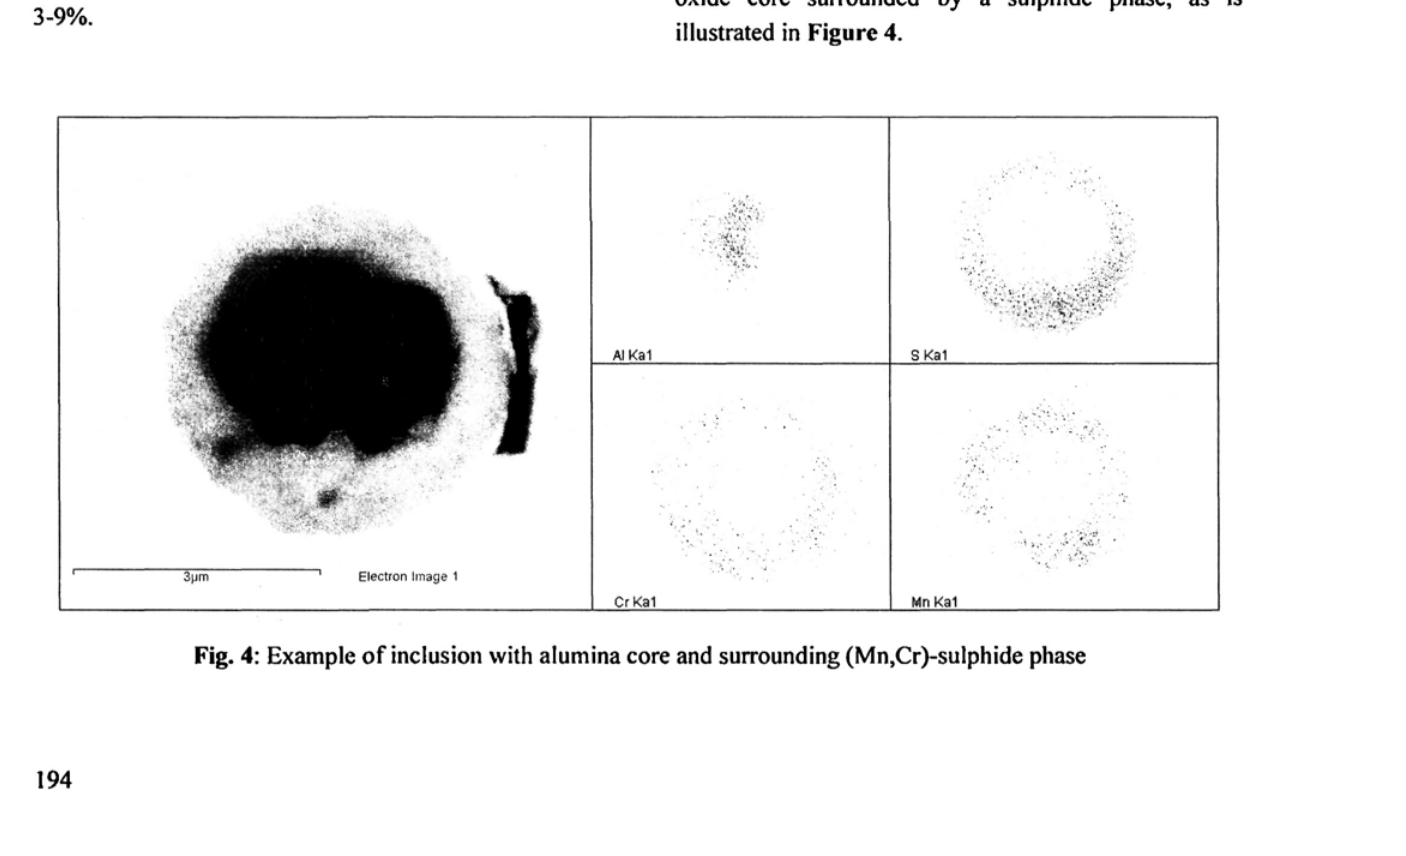
Fig. 3: Average composition in the inclusion of different trials related to added amount of CaSi.